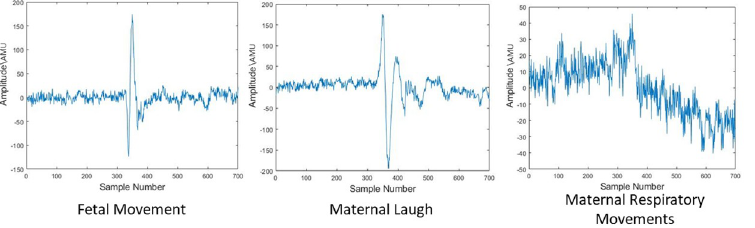
Fig 4. The accelerometric data of realizations from the three classes. The raw time domain data captured along the Z-Axis from the sensor are visualized in this figure. The first sub figure shows a realization of a fetal movement. The next sub figure shows a realization of a maternal laugh and the final sub figure shows a realization of a maternal respiratory movement. In all figures the recorded acceleration along the Z-Axis is plotted against the instance it is recorded.